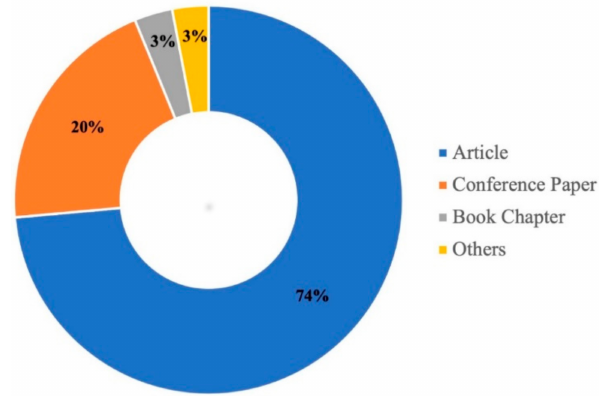
Figure 4. Types of scientific